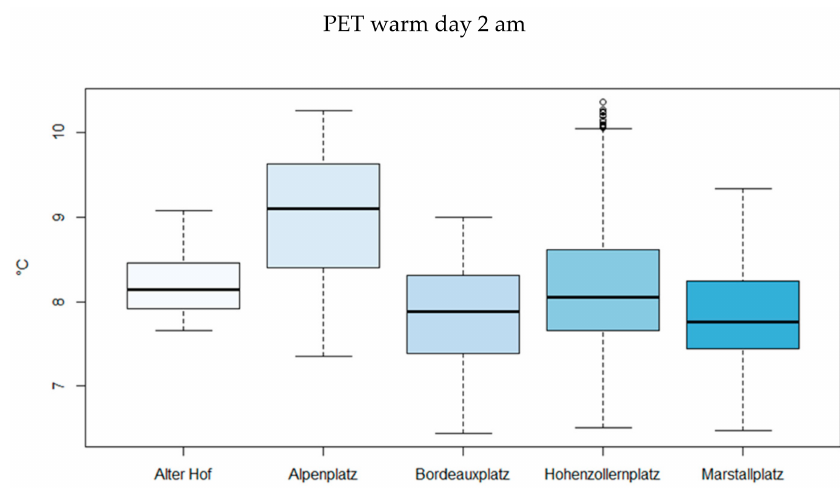
Figure 13. PET values for warm day at night (2 am).